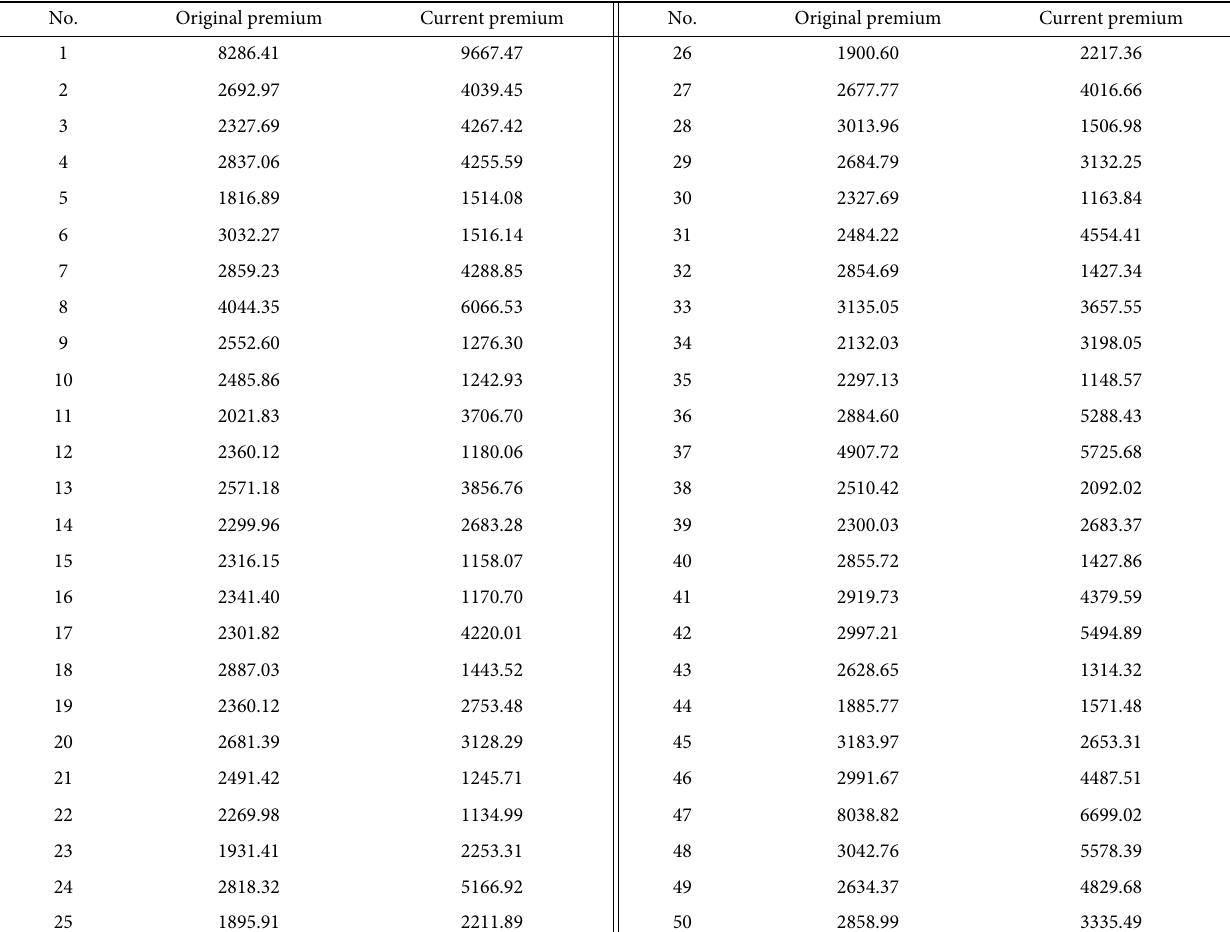
Table 8 Comparison between the premium and original premium calculated by UBI rate determination model based on driving behaviors.